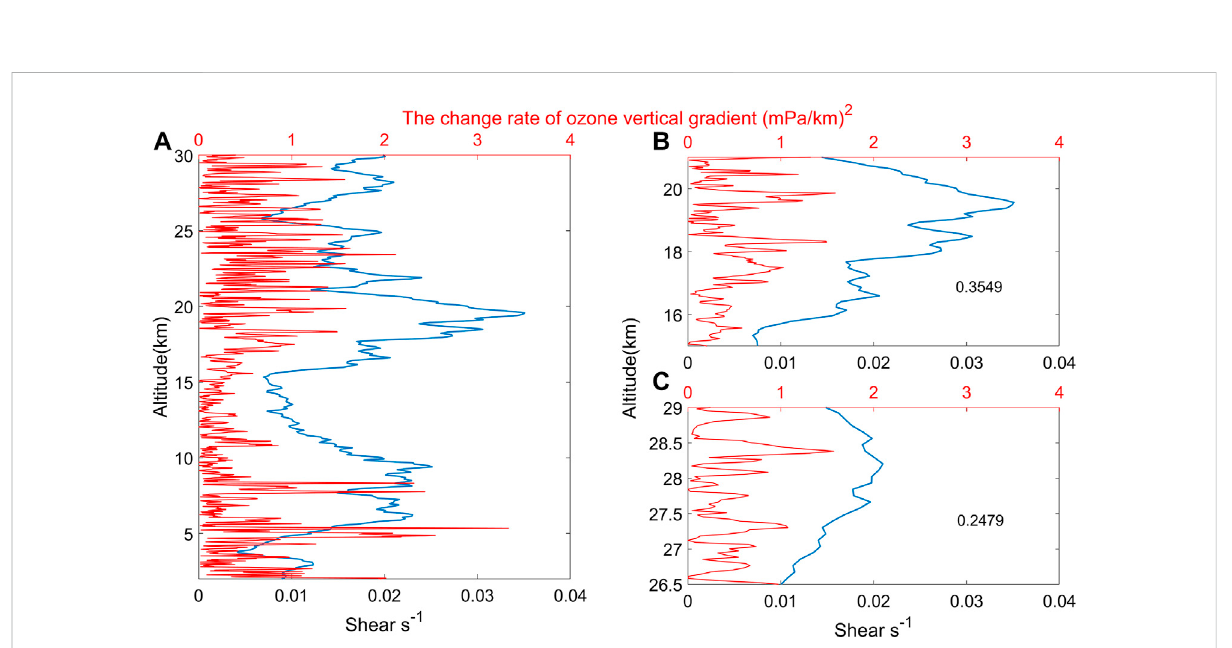
FIGURE 9 Distributions of the wind shear (blue line) and ozone gradient change rate gradient (red line) at different altitudes on 15 October 2021: (A) 2 – 30 km, (B) 15 – 21 km, and (C) 26.5 – 29